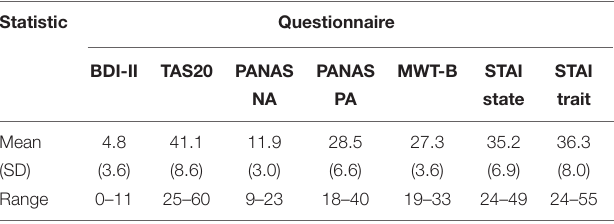
TABLE 1 | Descriptive statistics of questionnaire data ( N =